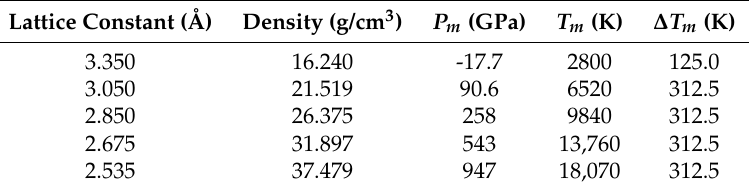
implemented with VASP.